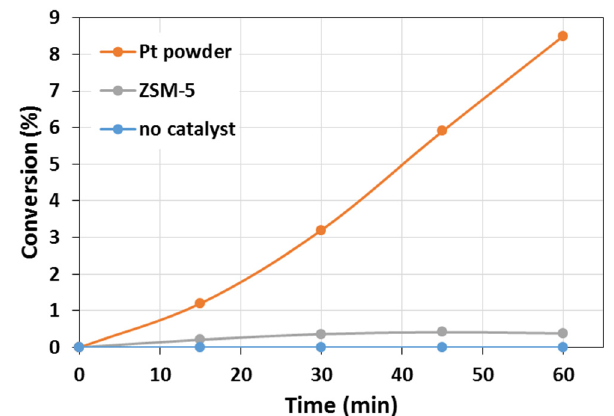
Figure 7. The conversion profiles of cyclohexene in the blank reactions as a function in the applied reaction time.